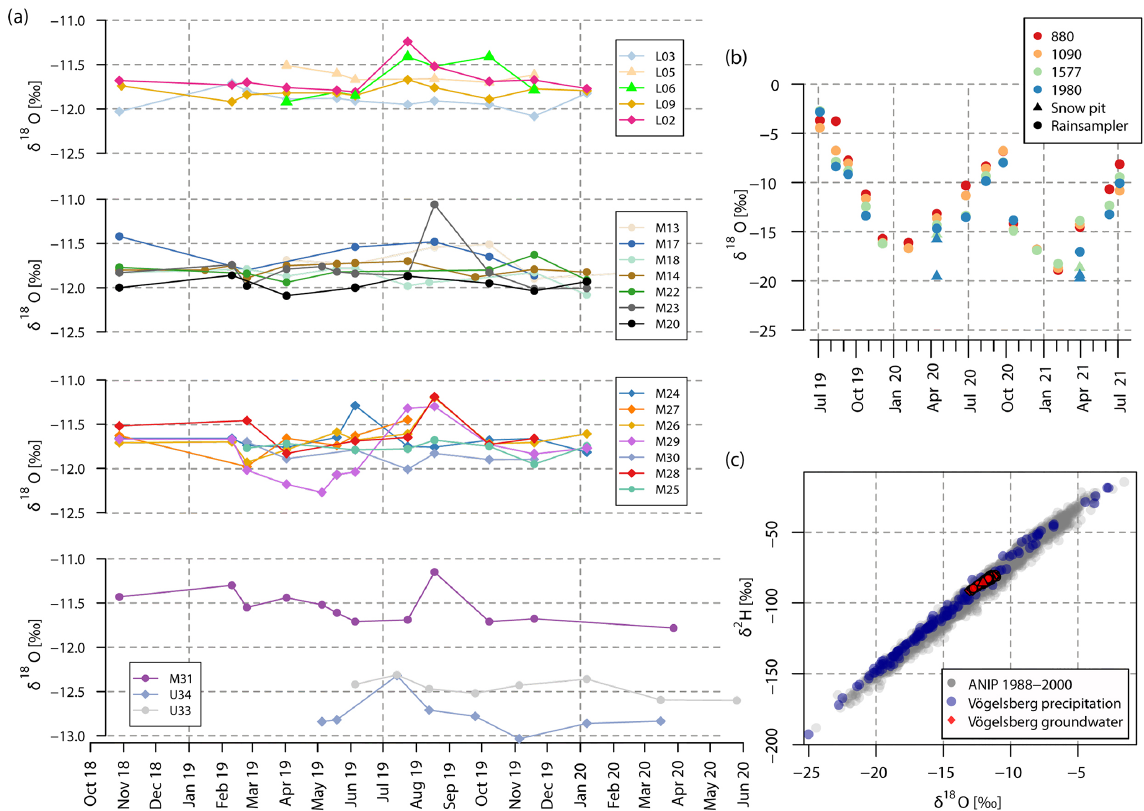
Figure 7. Time series of δ 18 O of selected springs (a) , time series of δ 18 O in precipitation (b) , and δ 18 O vs. δ 2 H in precipitation (ANIP and Vögelsberg) and groundwater (Vögelsberg) (c)